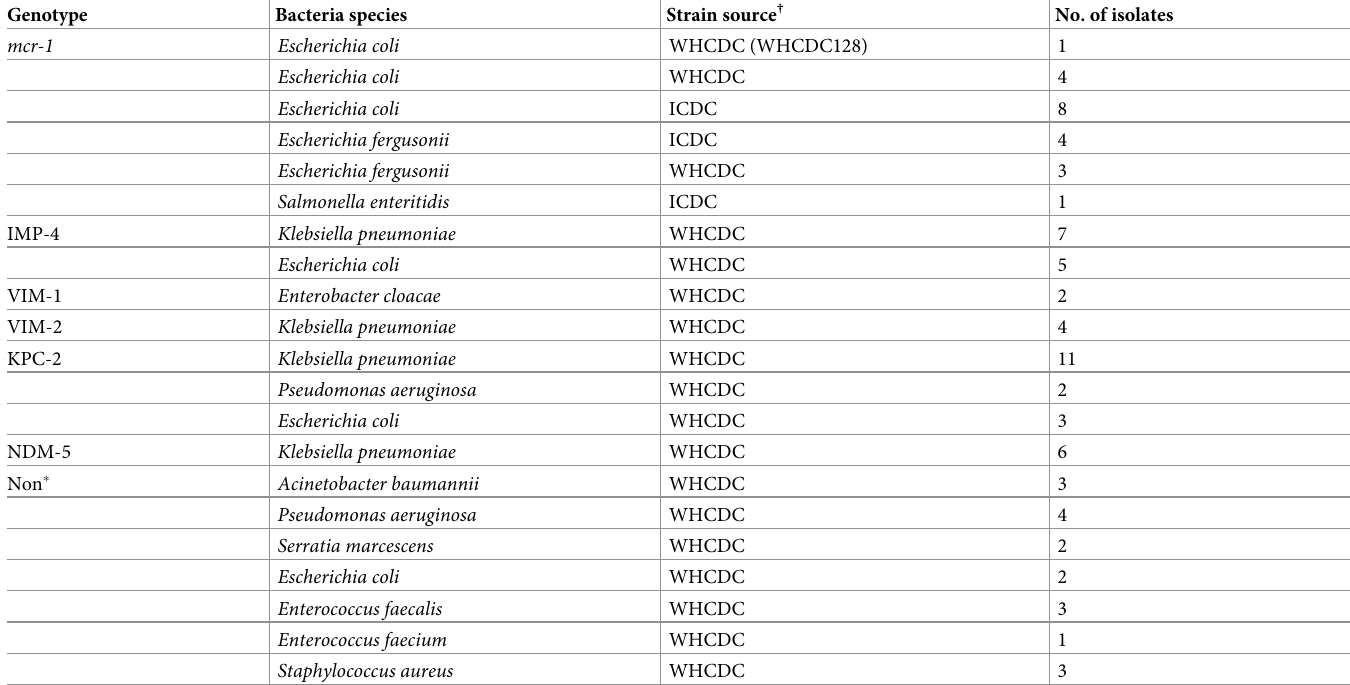
Table 1. Bacterial